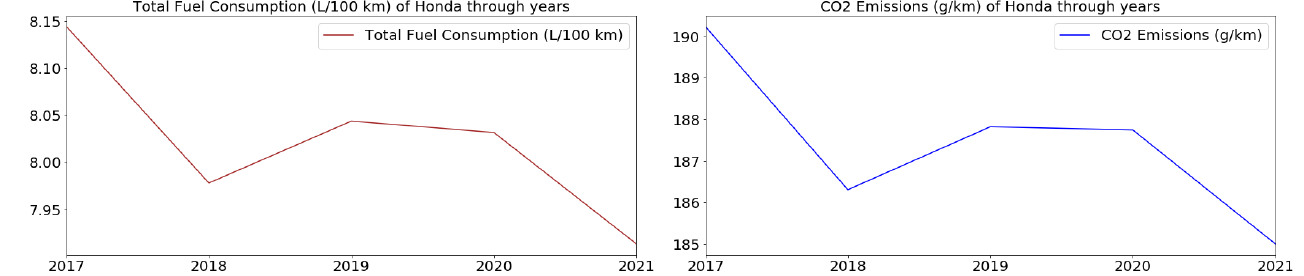
Figure 6. CO 2 emissions (g/km) and total fuel consumption (L/100 km) of Honda over time.